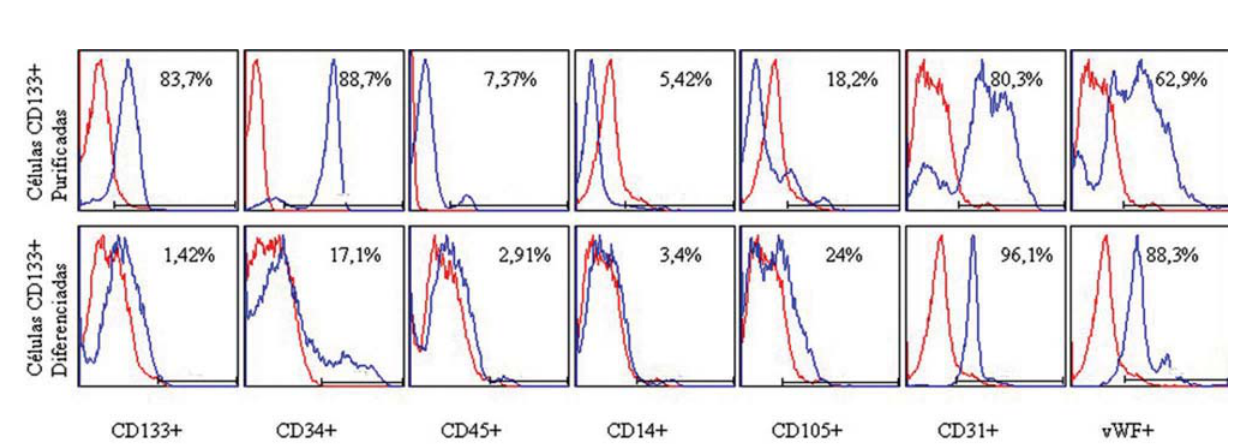
Fig. 1 - Caracterização fenotípica por citometria de fluxo de células CD133+ purificadas e diferenciadas. As células foram marcadas com anticorpos humanos fluorescentes anti-CD133, CD34, CD45, CD14, CD105, CD31 e vWF. Histogramas azuis identificam a porcentagem